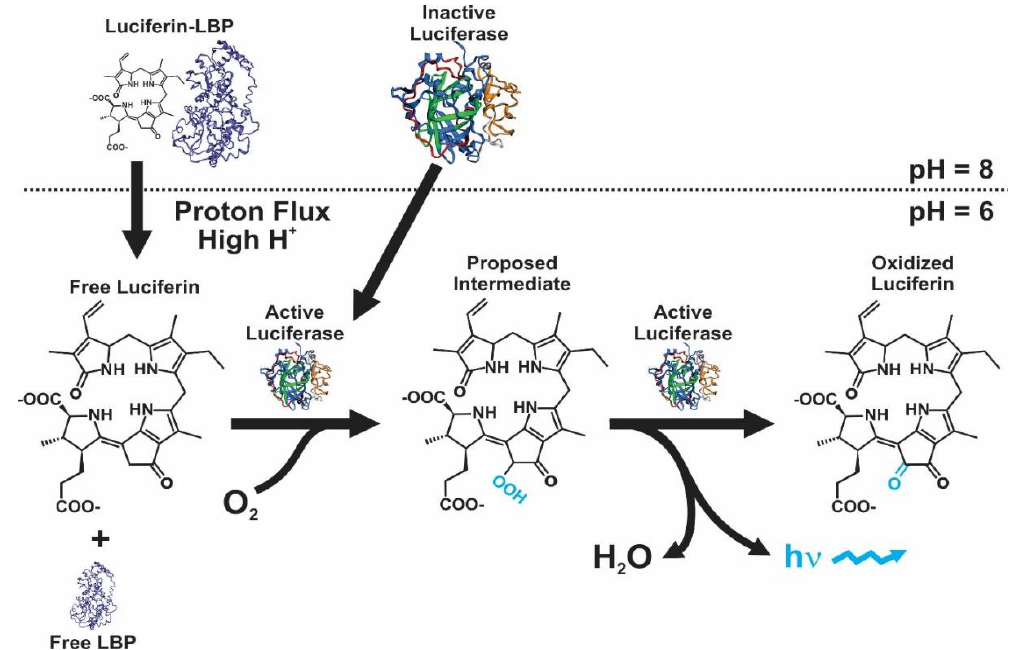
Figure 1. Bioluminescence model in dinoflagellates, showing the effect of pH on both LBP and LCF. Modified from the proposed model by Rüdiger Hardeland (http://tolweb.org/notes/?note_id=5621) and work published by Morse et al. [30]. The structure of LBP is not known, the one shown here it was obtained by using the P. lunula sequence into Phyre2 and it is shown for illustration purposes only. The structure of LCF shown here was predicted in Phyre2 using the P. lunula sequence, as explain in the text and in Figure 2. Table 1. Accession numbers of the sequences reported in GenBank for the luciferase (LCF), luciferin binding protein (LBP) and glutathione S-transferase (GST) in the species of microalgae.